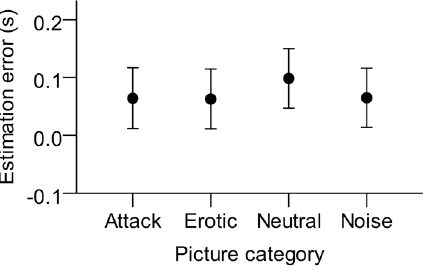
Figure 3. Mean TTC estimation errors (estimated TTC – actual TTC) as a function of picture category. Error bars represent ± 1 standard error of the mean across